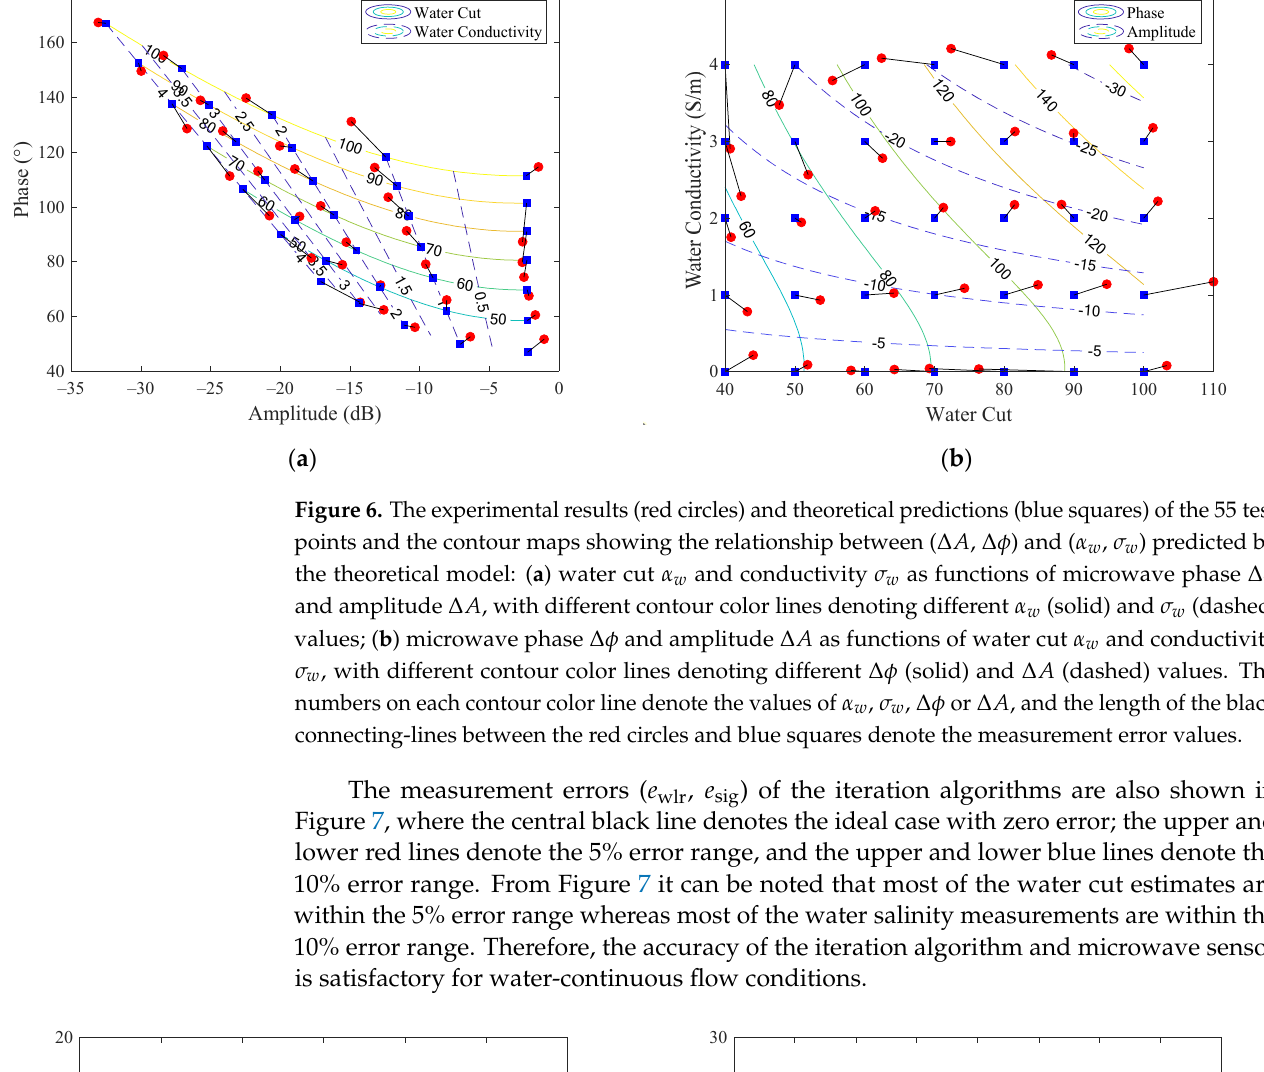
squares in Figure 6b.